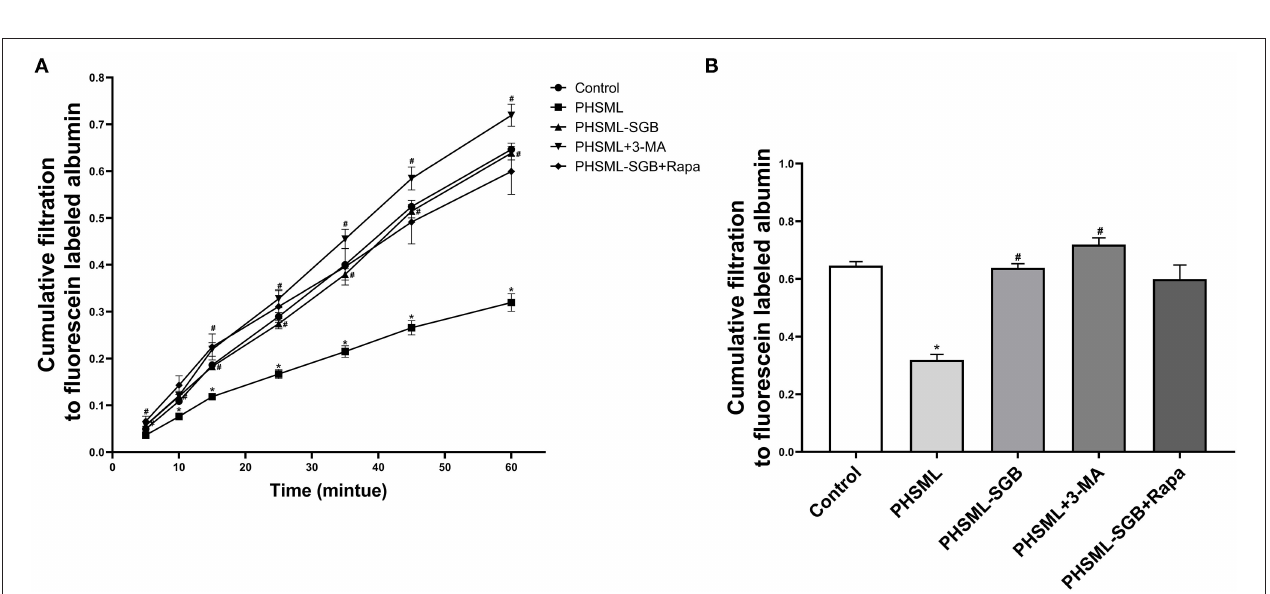
FIGURE 4 | Effect of SGB and autophagy drugs on the contractility of VSMCs injured by PHSML. The cells were treated with PHSML, PHSML-SGB (PHSML obtained from the rats underwent hemorrhagic shock plus SGB treatment), PHSML plus 3-MA (autophagy inhibitor, 5mM), and PHSML-SGB plus Rapa (autophagy activator, 100nM) for 6h, respectively. The cellular contractility to noradrenaline (final concentration of 0.5mM) was detected using the Transwell chamber and expressed with the cumulative filtration to fluorescence-labeled albumin. (A) Time-cumulative filtration curves. (B) Cumulative filtration to fluorescence-labeled albumin at 60min. The data are presented as mean ± SEM ( n = 6). Differences among groups were analyzed using the one-way ANOVA and the post hoc test with the SNK test. * P < 0.05, compared with the control group; # P < 0.05 compared with the PHSML group.